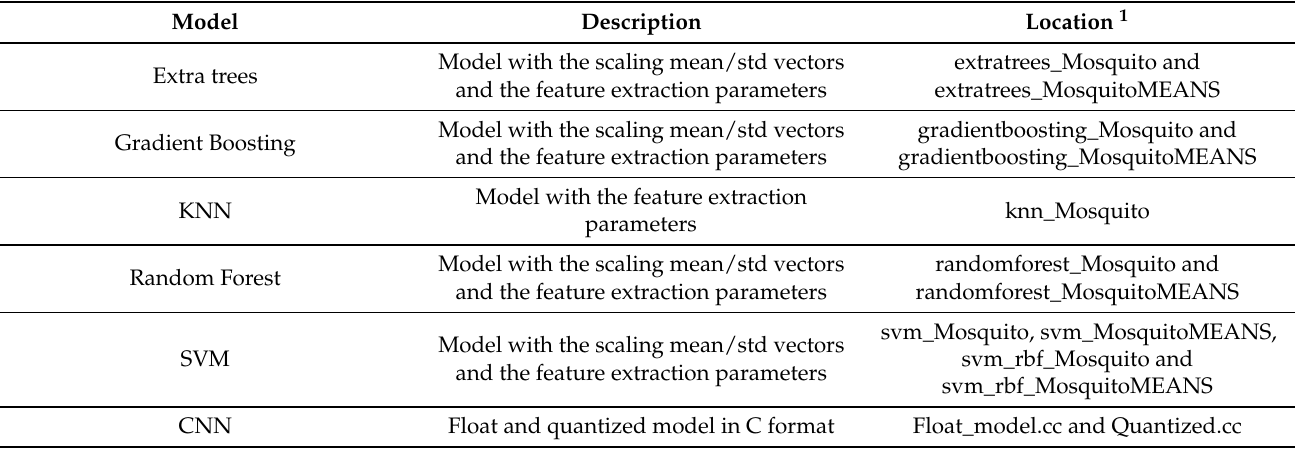
Table 9. Models’ file